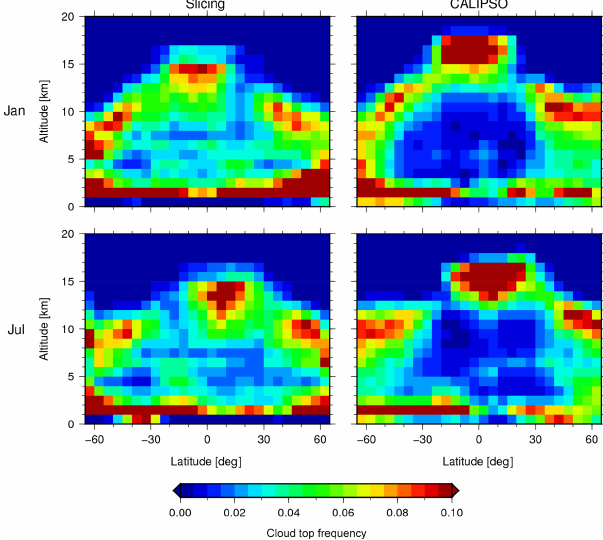
uppermost cloud top occurrence obtained from the slicing (left col- umn) and CALIPSO (right column) in January (top panel) and July (bottom panel). Zonally averaged values are shown within grid size of 5 ◦ horizontally and 1km